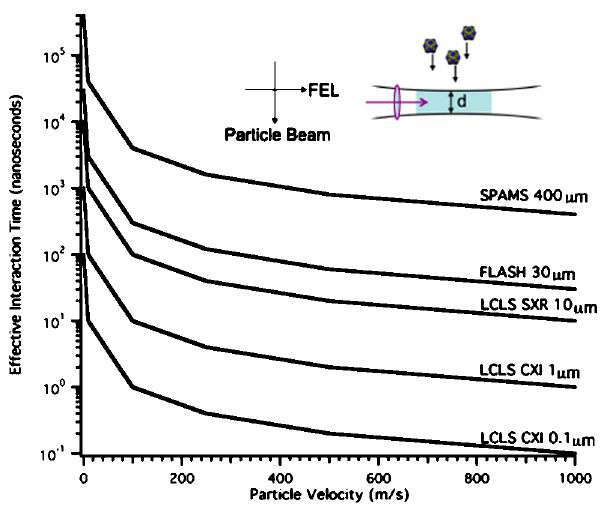
2. Estimated effective interaction time, t eff , in a perpen- dicular geometry, as a function of velocity for particles passing through laser interaction regions with diameter d